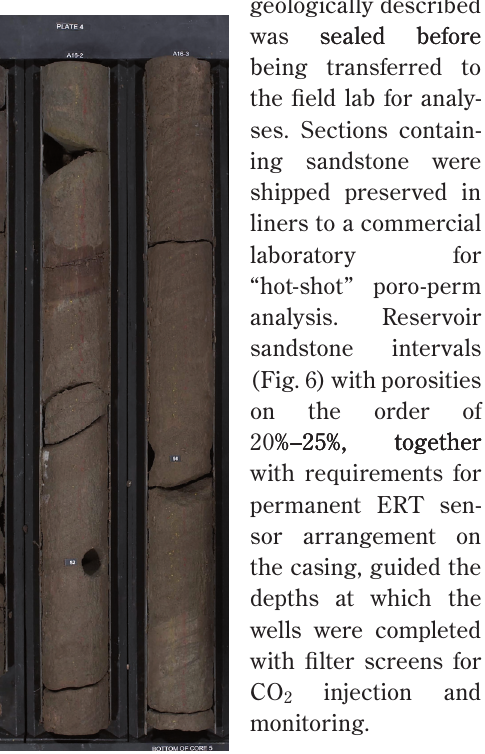
Figure 6. Core image of reservoir sand- stone showing